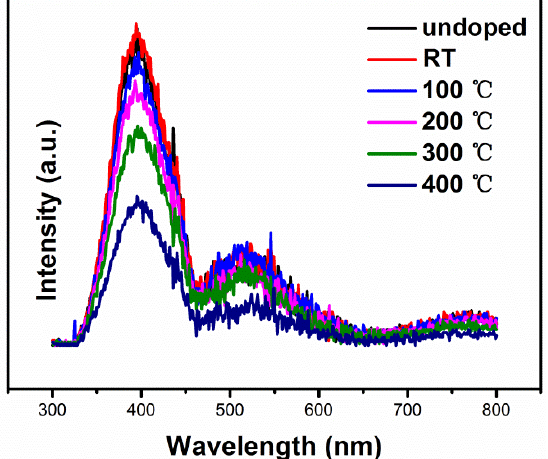
Figure 11. Room-temperature photoluminescence (PL) spectra of NiO thin films deposited at different substrate temperatures.